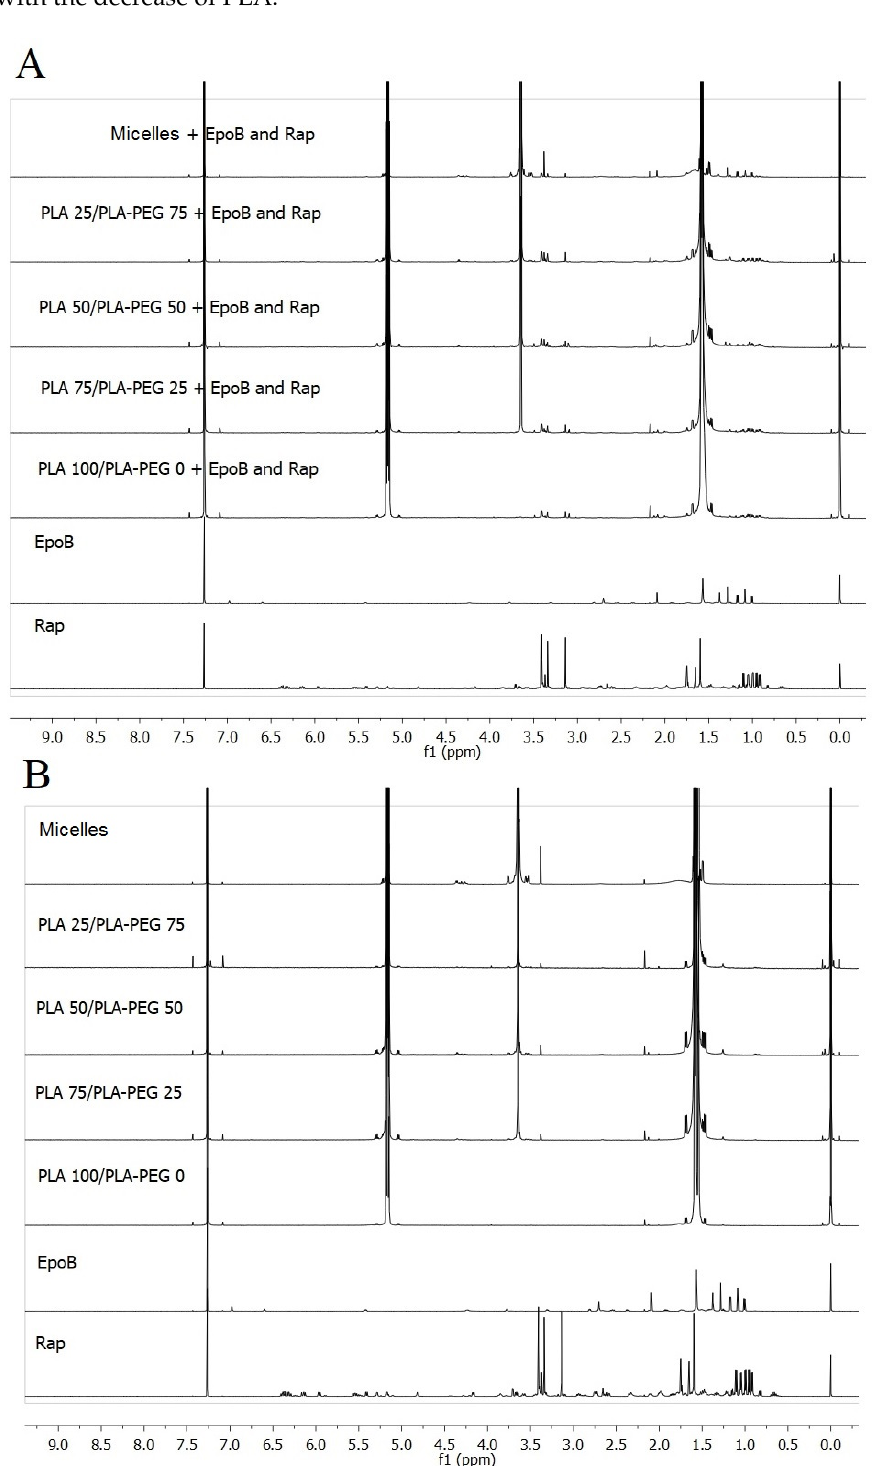
Figure 3. Comparison of 1 H nuclear magnetic resonance (NMR) spectra in CDCl 3 of free drugs and drugs-loaded delivery systems ( A ) or drug-free delivery systems ( B ).